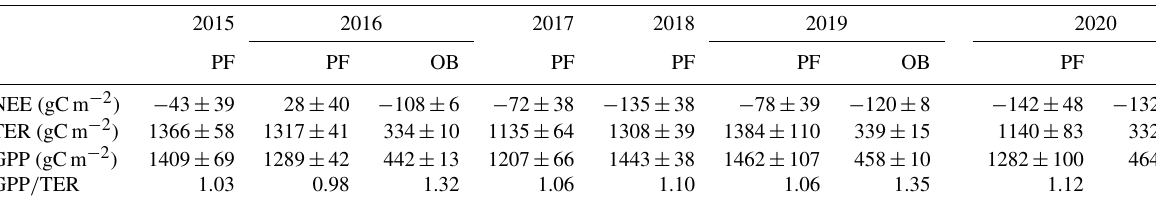
Table 4. Growing season (calculated for long-term mean growing season 12 April–11 October) sums of net ecosystem exchange (NEE), total ecosystem respiration (TER), gross primary production (GPP), with uncertainty estimates associated with random error in the measured fluxes, u ∗ threshold estimation, gap-filling and flux partitioning procedures ( ± SD), and GPP / TER ratio at the paludified forest (PF) and at the ombrotrophic bog (OB) in the period 2015–2020.